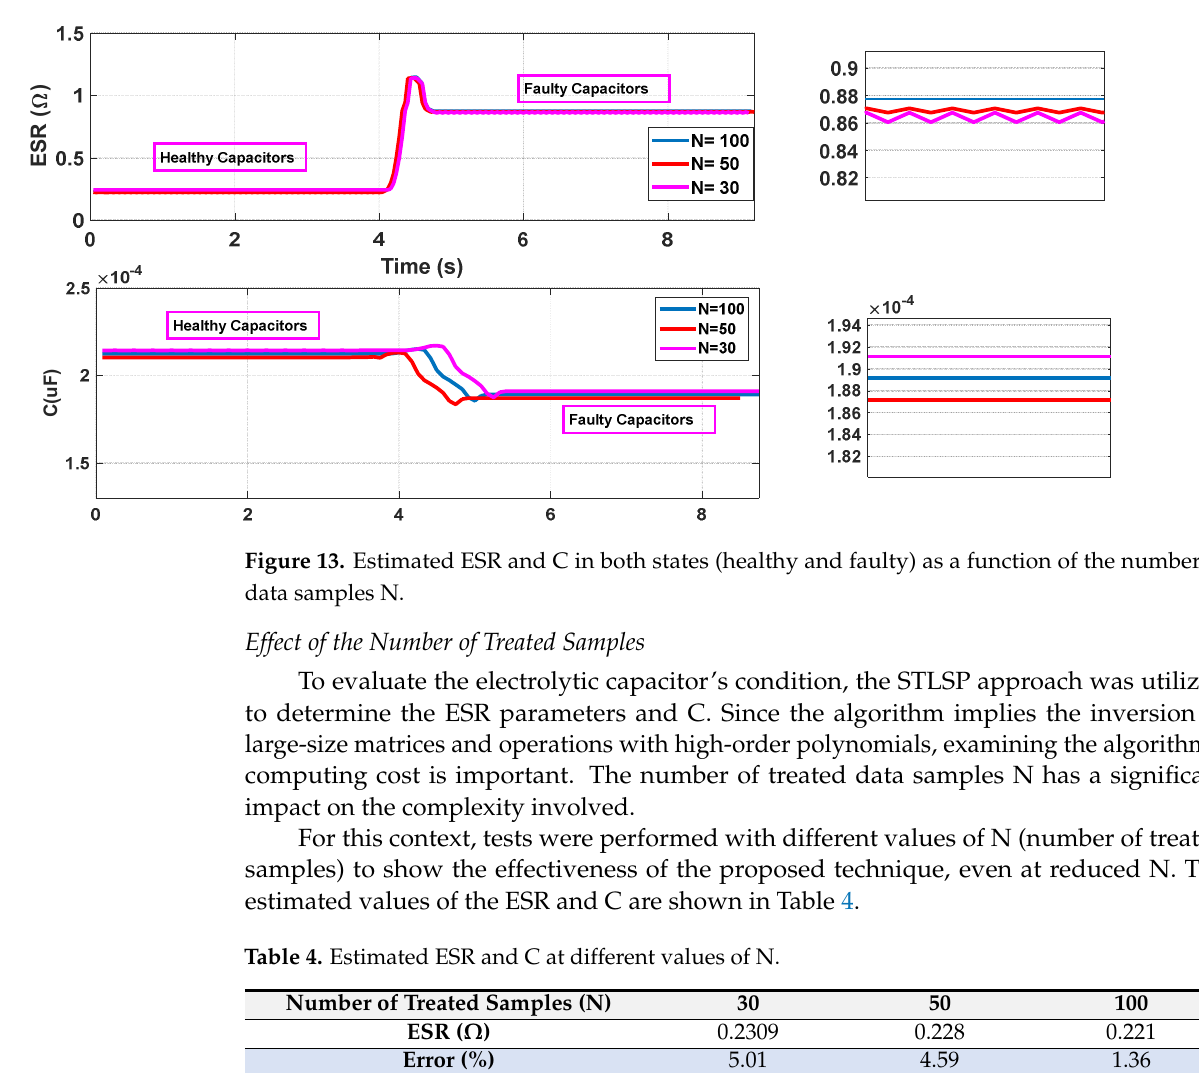
Figure 12. Estimated ESR and C in both states (healthy and faulty).